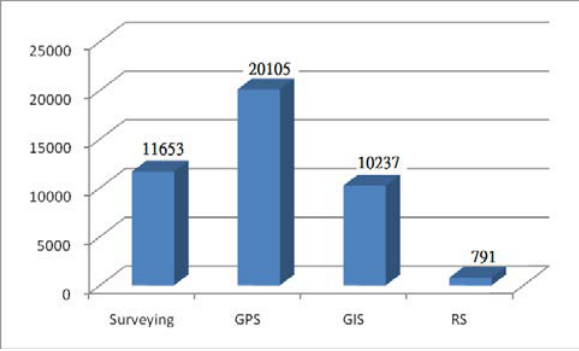
Figure 6. The average downloads. Figure 7 is the average votes for each category. The highest grade of votes in Google Play is 5. All these categories were higher than grade 4. Although these Apps could not provide high accuracy measurement, most people are satisfied with these Apps.